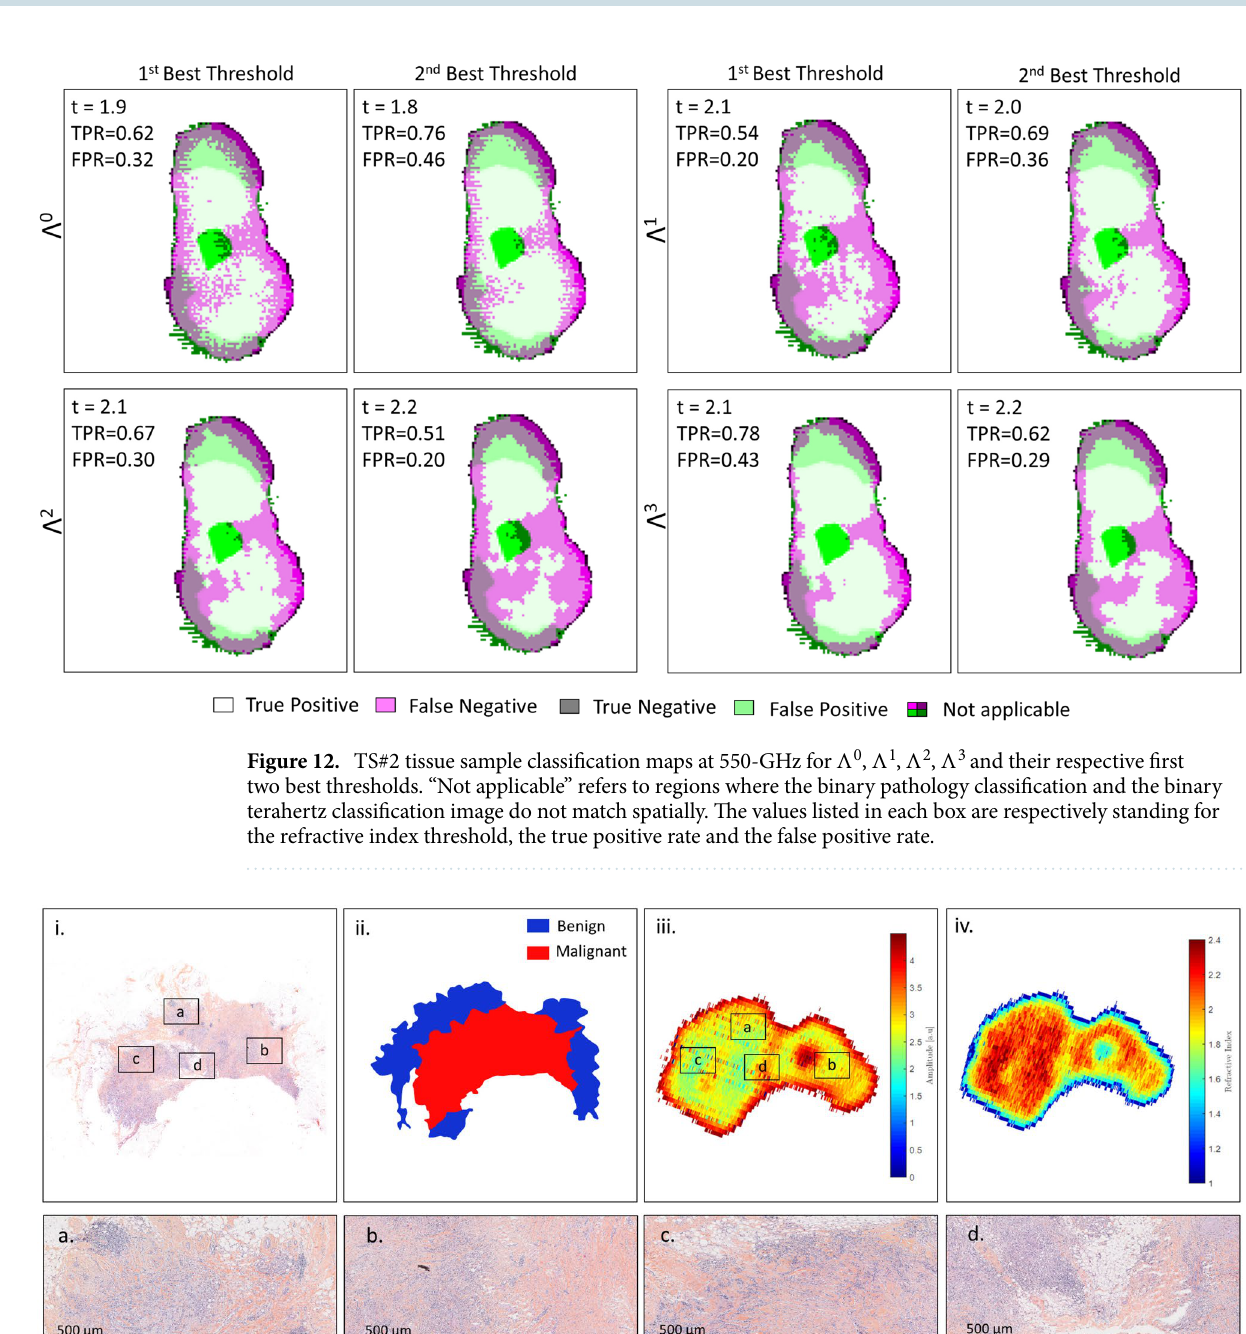
Figure 13. Sample TS#3. (i) Pathology image and correlated view of the respective zones ( a , b , c , d ); (ii) pathology mask; (iii) raw terahertz image at 550-GHz; (iv) refractive index map at